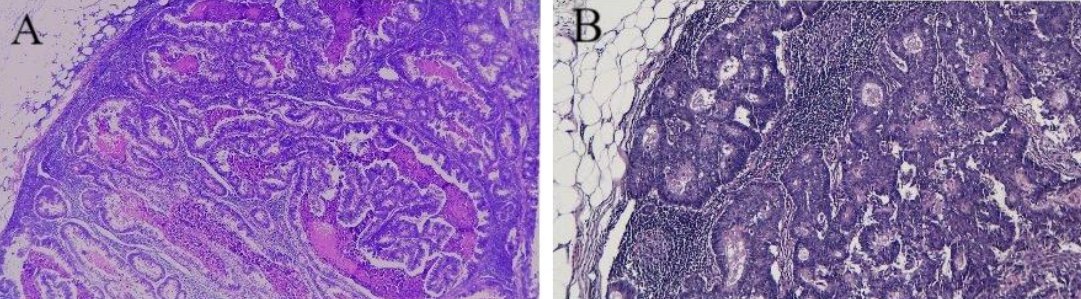
Figure 3. Pathological examination of LN. ( A ) HE, 4x: metastasis of colorectal adenocarcinoma in lymph node — there is epithelial neoplastic proliferation with cribriform pattern and comedonecrosis. ( B ) HE, 4x: cribriforming neoplastic glands delimited by atypical cylindrical epithelium, with comedonecrosis.